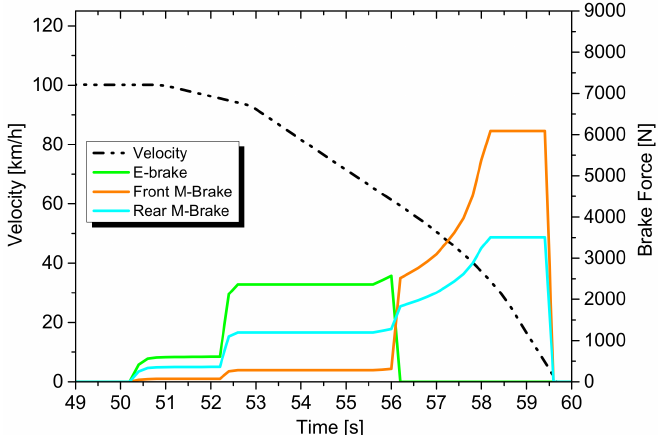
Figure 18. Braking force distribution in the racing